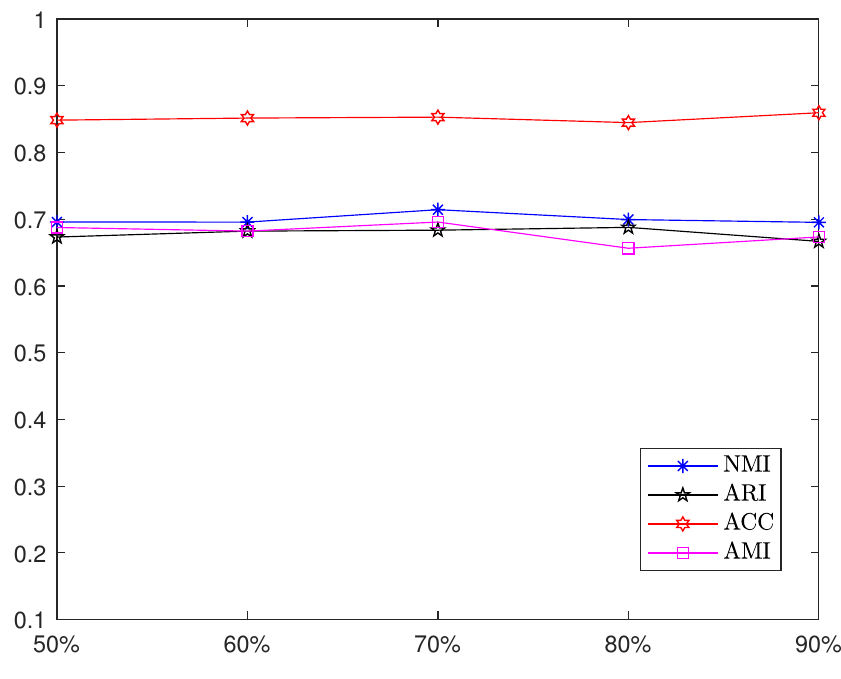
Figure 5. Results of Forrest by